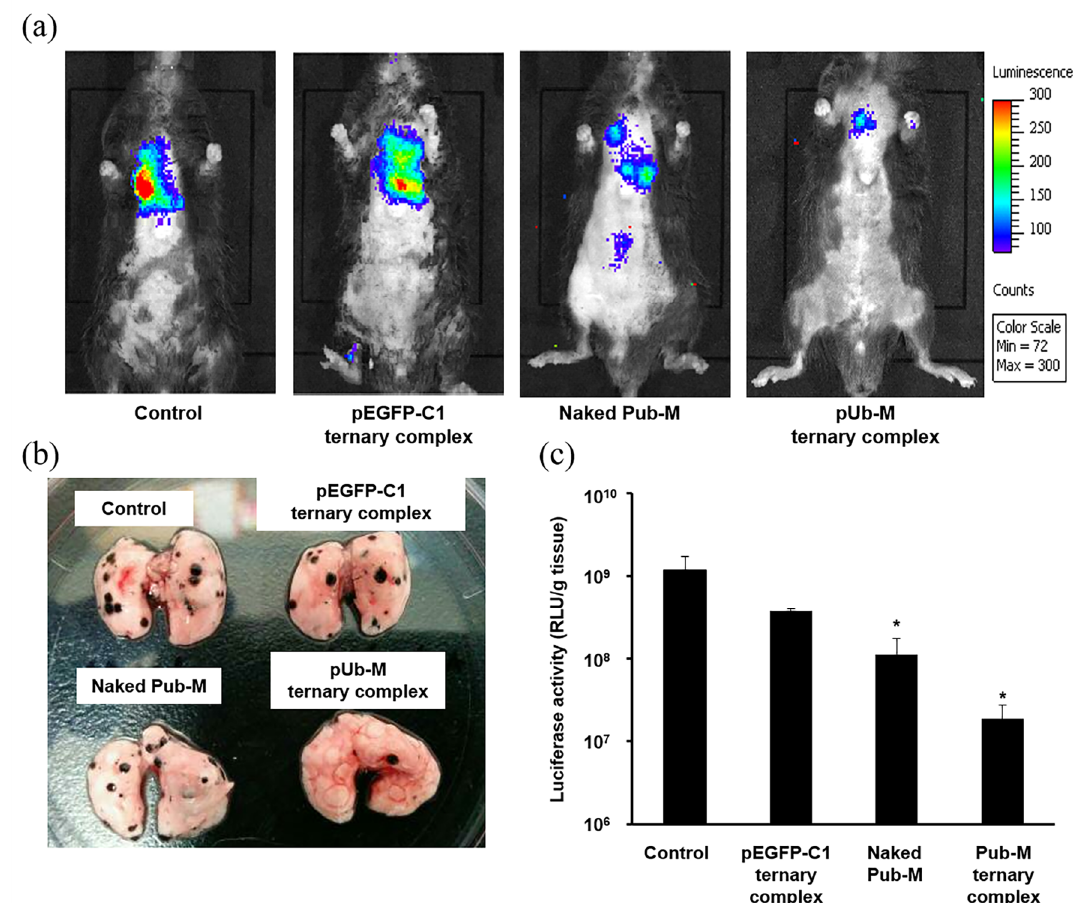
Figure 4. Cancer vaccine e ff ects against lung metastatic tumors by DNA vaccination. Suppressive e ff ects on pulmonary metastatic tumors were evaluated by DNA vaccination using control, naked pUb-M, the pUb-M ternary complex, or pEGFP-C1 ternary complex (50 µ g of pDNA). Two weeks after the last immunization, B16-F10-Luc cells (for the evaluation of tumor metastasis) were injected intravenously (1 × 10 5 cells) into mice. Pulmonary metastatic tumors three weeks after the tumor injection were evaluated by IVIS imaging ( a ) and luciferase activity ( c ) ( n = 3, each value represents the mean ± S.E.). * p < 0.05, vs. control. Photograph of a B16-F10-derived pulmonary metastatic tumor three weeks after the tumor injection in mice immunized by each transfection method ( b ).